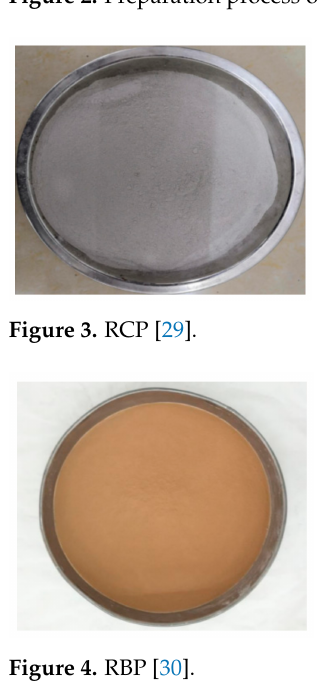
Figure 2. Preparation process of RP in laboratory.